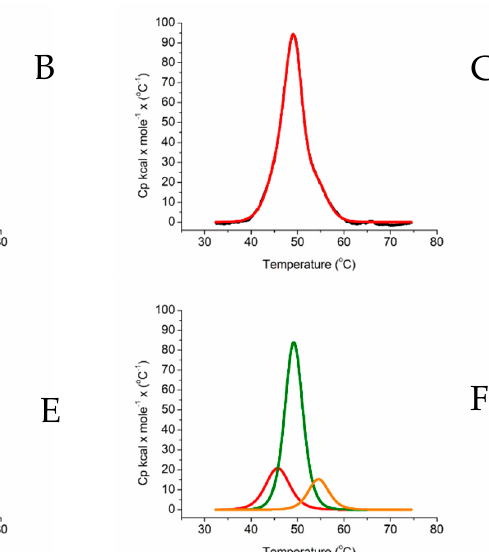
7 of 17 Figure 3. Thermal unfolding measured by DSC of ARO ‐ BMR chimeras. Thermograms of ( A ) ARO ‐